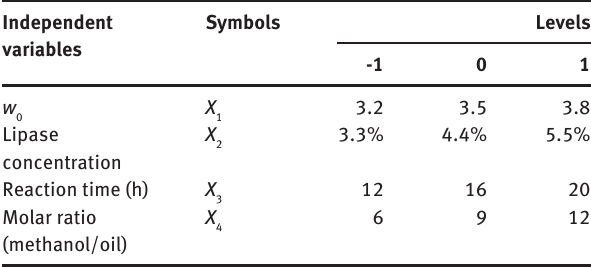
w , molar ratio of water to surfactant. 0